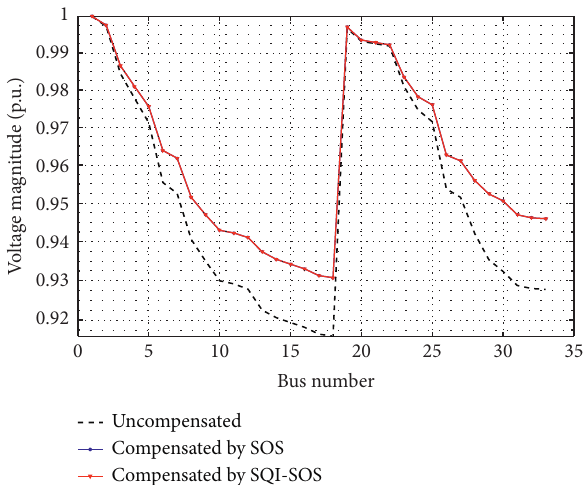
Figure 7: Voltage profile of the 33-bus system before and after compensation with the mixed load